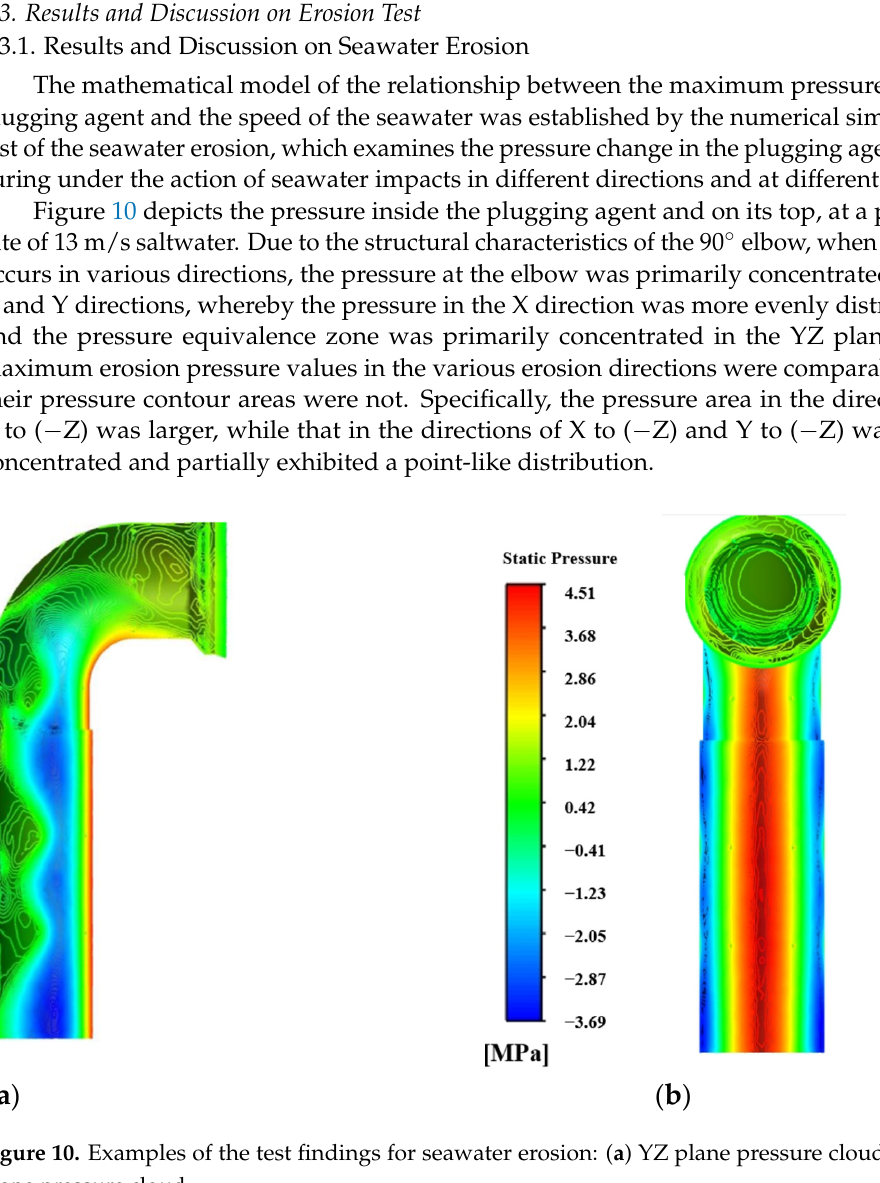
Figure 9. Test fi ndings for the pipe wall bonding strength of the plugging agents: ( a ) the tensile displacement variant; ( b ) each group’s greatest tensile strength.